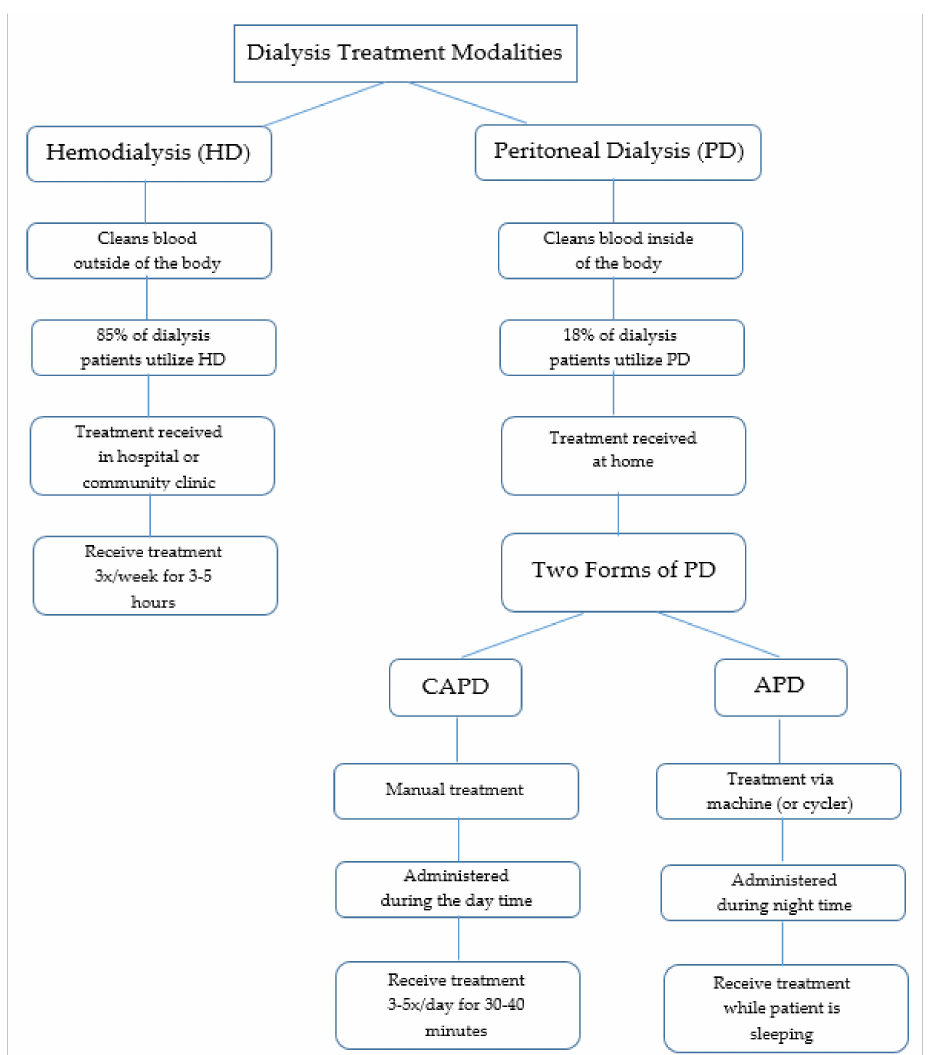
Figure 1. Overview of dialysis treatment